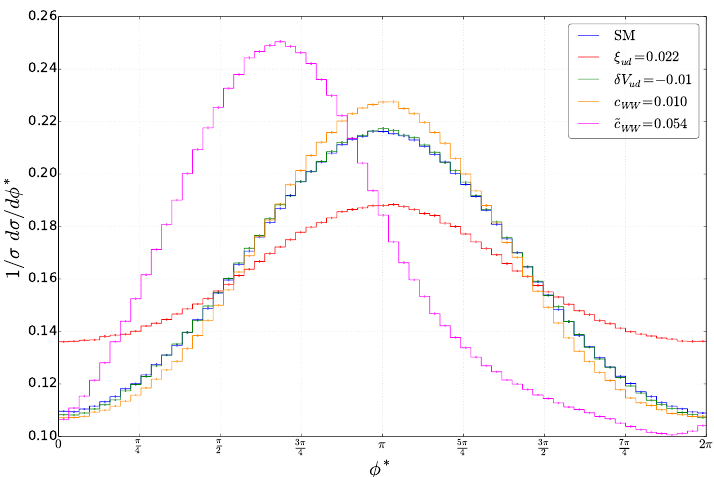
p S = 14 TeV, in the SM (blue